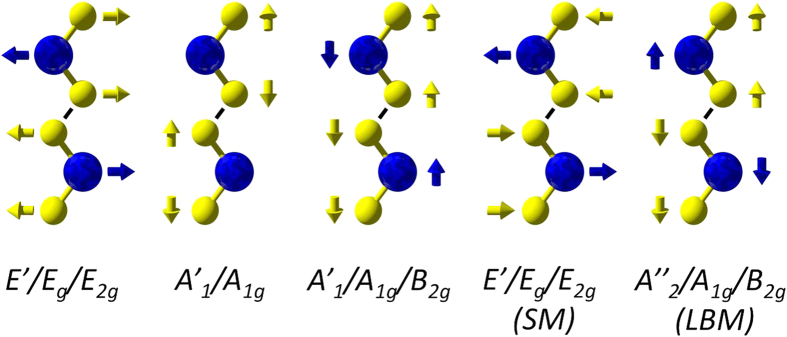
Schematic representation (ball and stick model) of Raman active modes in TMDs with the relative odd/even/bulk symmetry label indicated for each mode.Blue balls represent transition metal atoms; yellow balls represent chalcogen atoms, with arrows showing direction of motion.